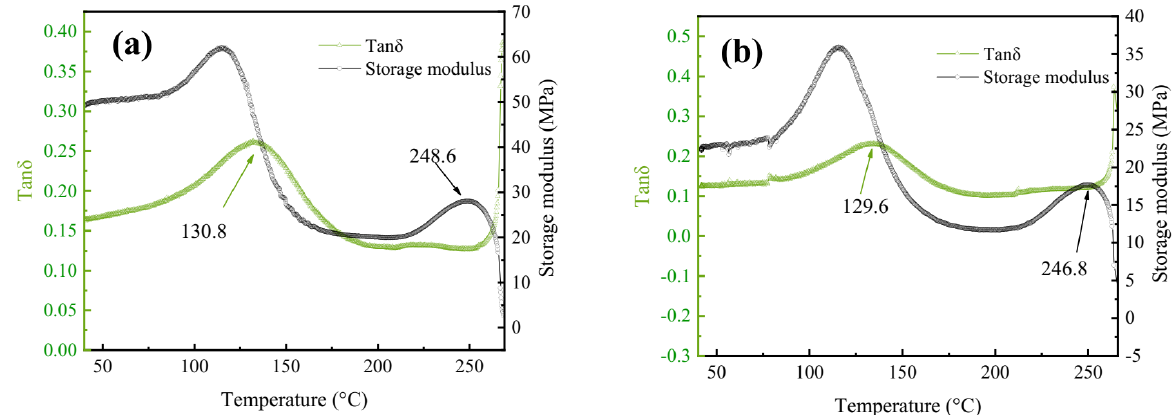
Figure 6. DMA curves of the polyester fabrics before ( a ) and after treatment ( b ): E’ (storage modulus) and tan δ (damping factor) are used as the main evaluation indicators here.